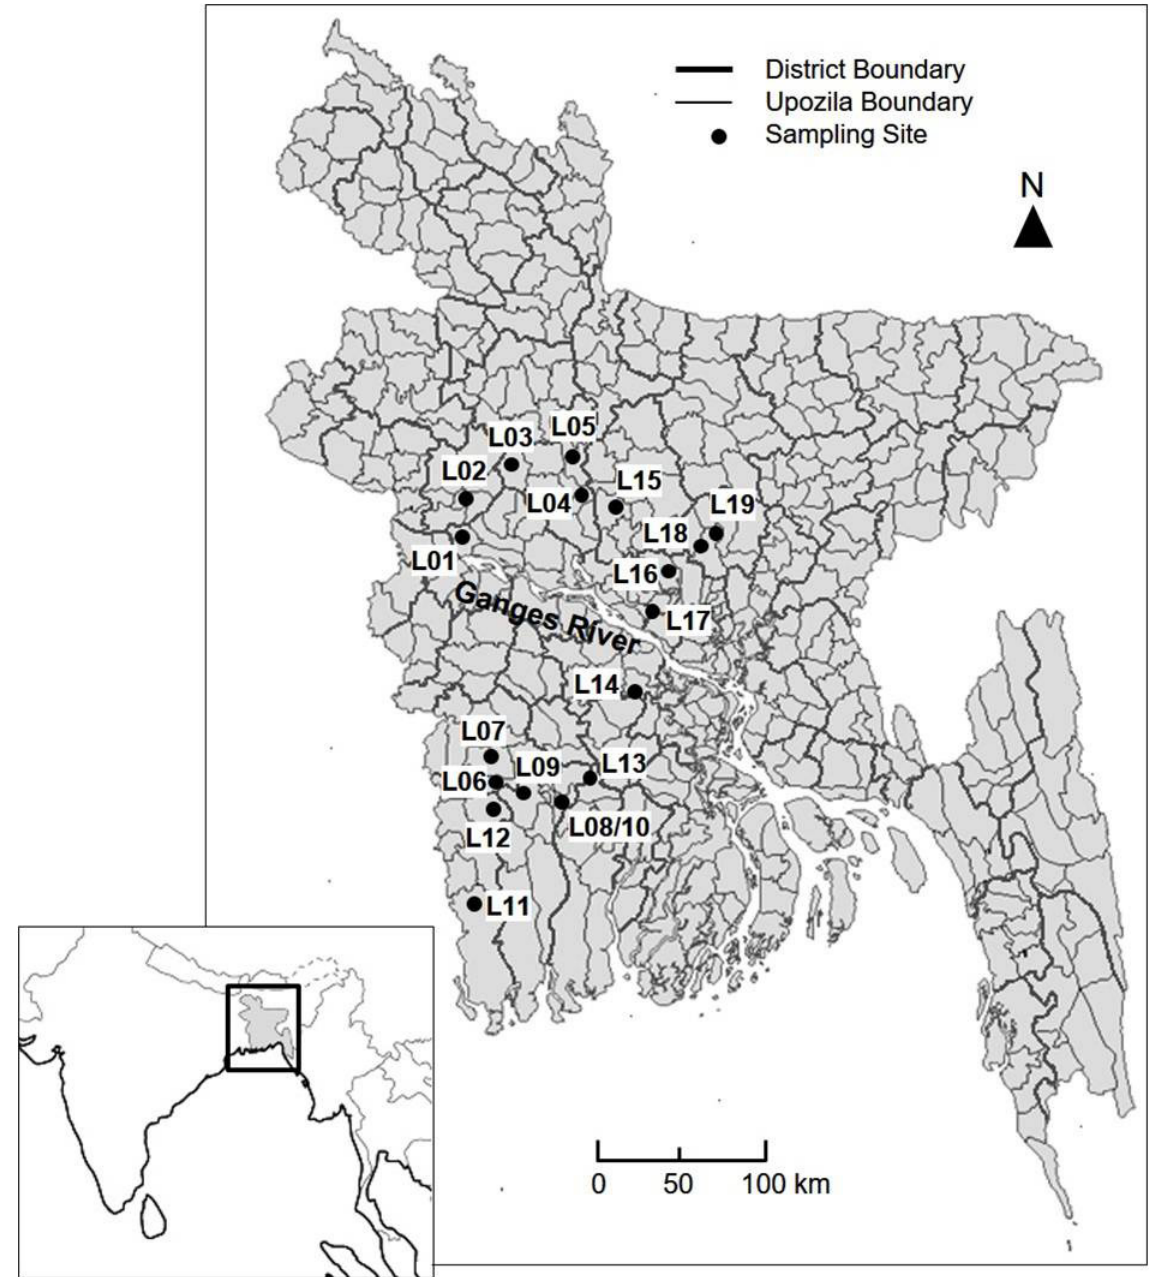
Fig 1 . The sampling sites of Oecophylla smaragdina in Bangladesh. Locality codes correspond to those in Table